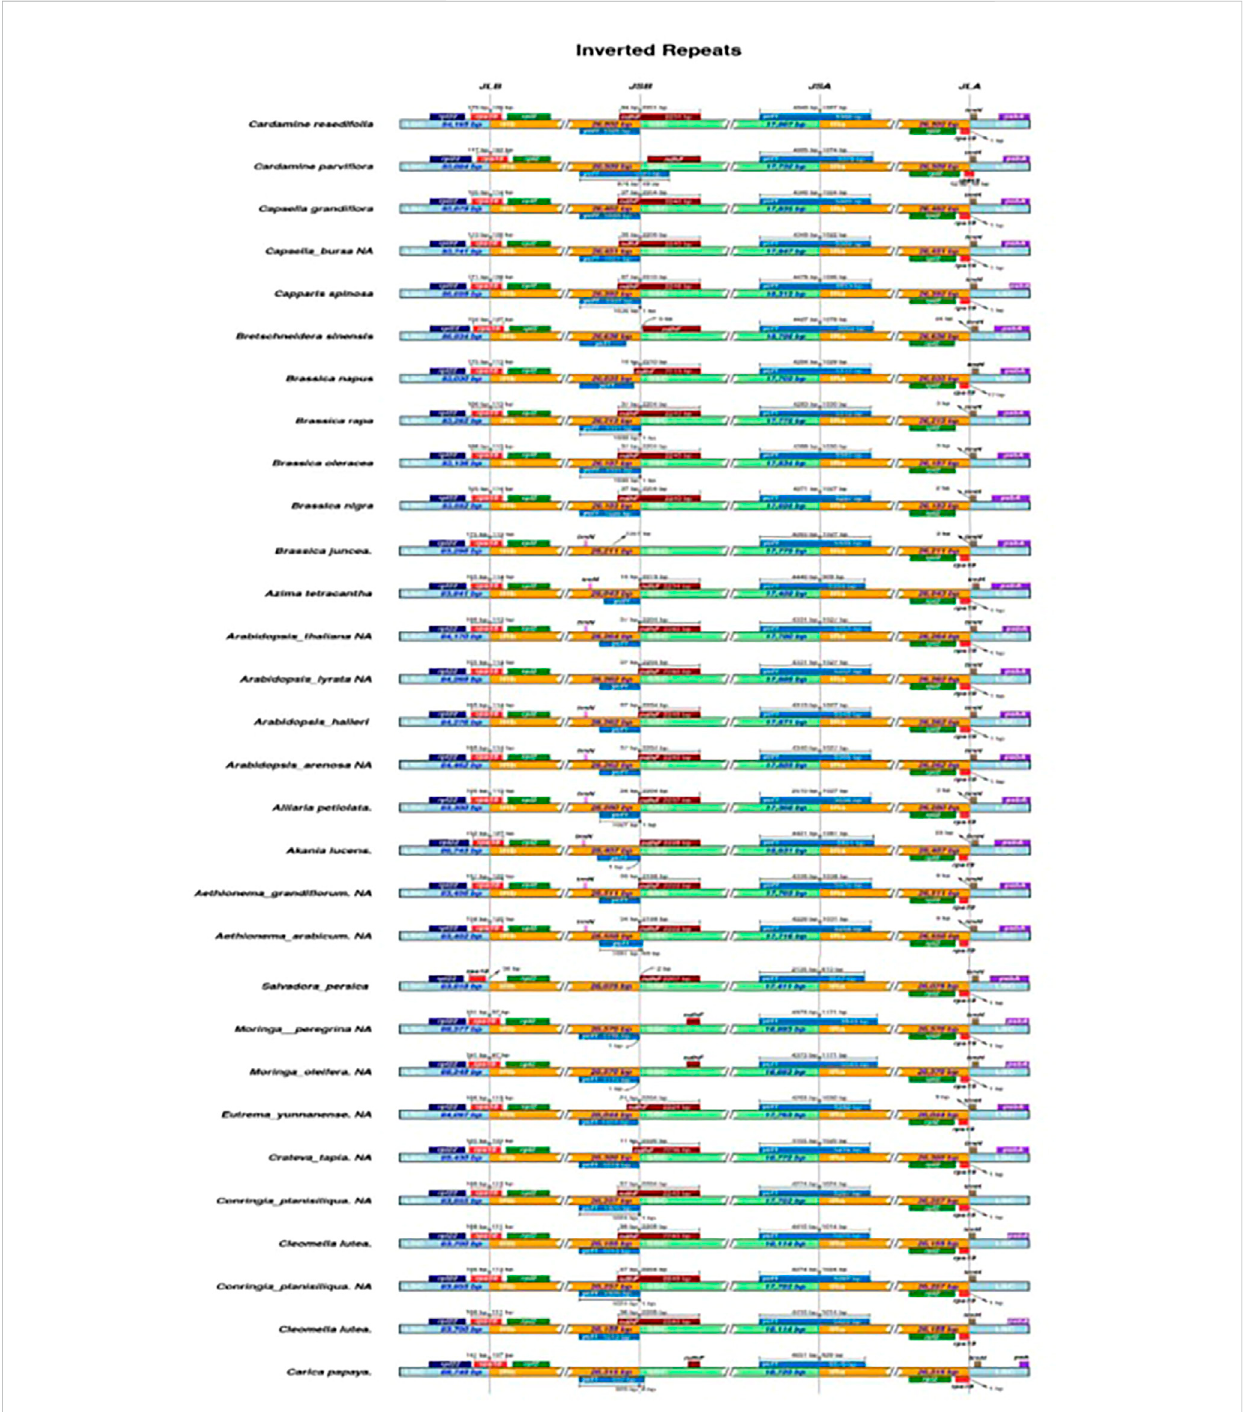
FIGURE 2 Distance between abjection genes and junctions of the small single copy(SSC), long single copy (LSS) and two inverted repearts regions (IR) of M. peregrina with 26 related species plastomic structures. The fi gure only shows the relatives changes at or near to IR/SC